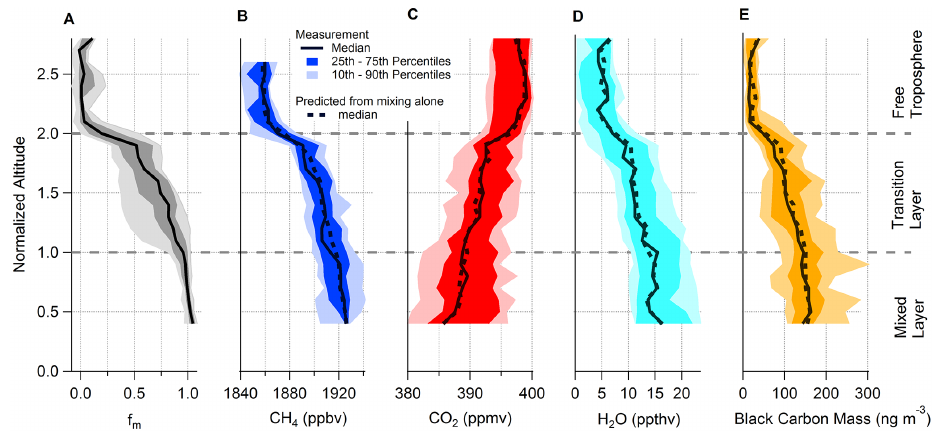
Figure 8. Altitude-normalized aggregate profile of (a) fraction of mixed layer air (Eq. 4), (b) CH 4 , (c) , CO 2 , (d) H 2 O, and (e) black carbon aerosol mass. The dashed line shows the concentrations expected from vertical mixing alone (Eq. 3). The shaded regions show the interdecile range (light) and the interquartile range (medium), and the solid lines are the median (dark). These trace gases and black carbon aerosol mass are not expected to be enhanced or reduced in the transition layer. The agreement between the observations and the concentration expected from vertical mixing alone demonstrates that CO can be used to quantify the fraction air from the mixed layer.